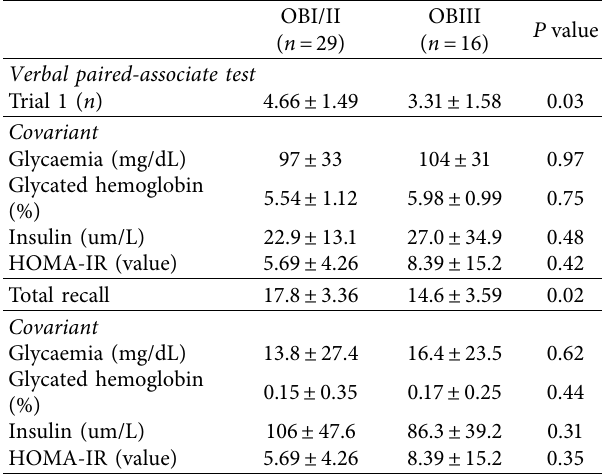
Table 5: Cognitive VPA test using blood glucose indicators as covariates.